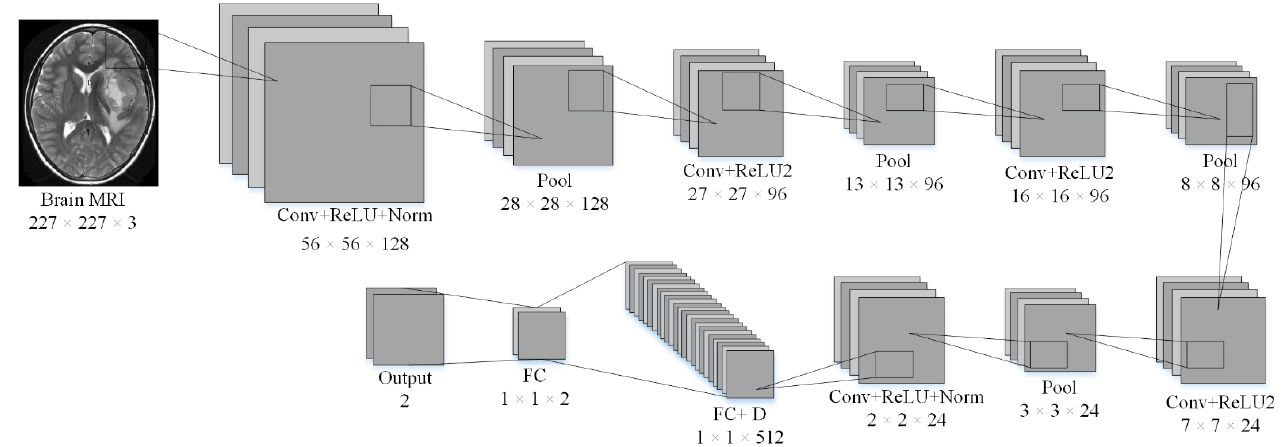
Figure 1. The architecture of the isolated-CNN model was built from scratch.